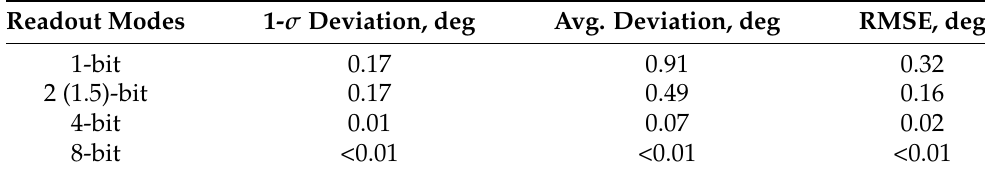
Table 5. Test configuration 1 accuracy measurements